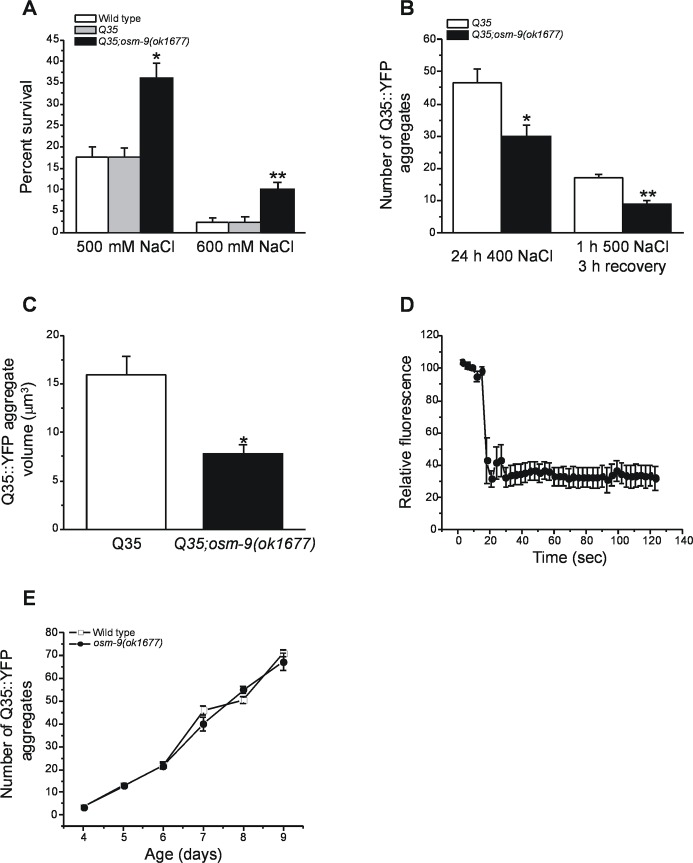
Hypertonic stress induced aggregation of Q35::YFP in body wall muscle cells of osm-9(ok1677) mutant worms.(A) Survival of wild type N2, Q35::YFP and Q35;osm-9(ok1677) worms exposed to 500 or 600 mM NaCl for 24 h. Values are means ± S.E. of 6 experiments. *P<0.001 and **P<0.01 compared to wild type N2 and Q35 worms. (B) Hypertonic stress induced Q35::YFP aggregation in wild type Q35 worms and Q35;osm-9(ok1677) mutants. Values are means ± S.E. of 4 experiments with a total of 32–78 worms. The number of Q35::YFP aggregates was quantified in worms exposed to 400 mM NaCl for 24 hour or 500 mM NaCl for 1 h followed by 3 h recovery on control medium. Values are means ± S.E. (n = 3). *P<0.005 and **P<0.001 compared to wild type Q35 worms. (C) Q35::YFP volume in wild type Q35 worms and Q35;osm-9(ok1677) mutants. Worms were exposed to 500 mM NaCl for 1 h and then allowed to recover on control medium before aggregate volumes were quantified. Values are means ± S.E. (n = 20 aggregates in 5–6 worms). *P<0.0004 compared to wild type Q35 worms. (D) Time course of bleaching and fluorescence recovery of Q35::YFP aggregates in Q35;osm-9(ok1677) mutant worms. Aggregates were induced by exposing worms to 500 mM NaCl for 1 h. FRAP analysis was performed 3 h after worms were returned to 51 mM NaCl medium. Values are means ± S.E. (n = 7 aggregates in 4 worms). (E) Time course of aging induced Q35::YFP aggregation in wild type Q35 worms and Q35;osm-9(ok1677) mutants. Values are means ± S.E. (n = 3).